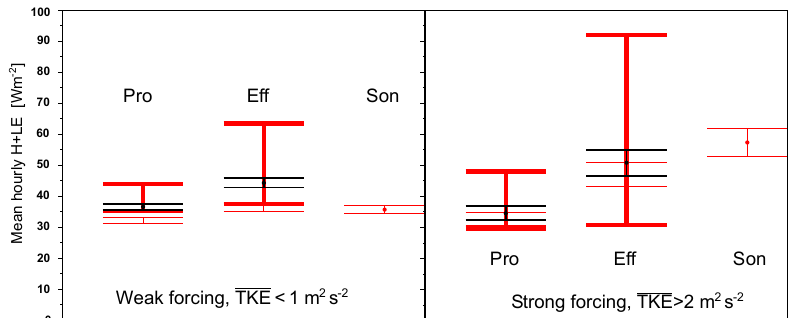
Figure 8. Comparison of mean net turbulent fluxes from the profile method and the sonic method. For the profile method we show the reference fluxes and their random errors in black, in thick red the maximum fluxes and in thin red minimum fluxes (with their random error) as derived from the Monte Carlo analysis, and the net sonic fluxes to the right in thin